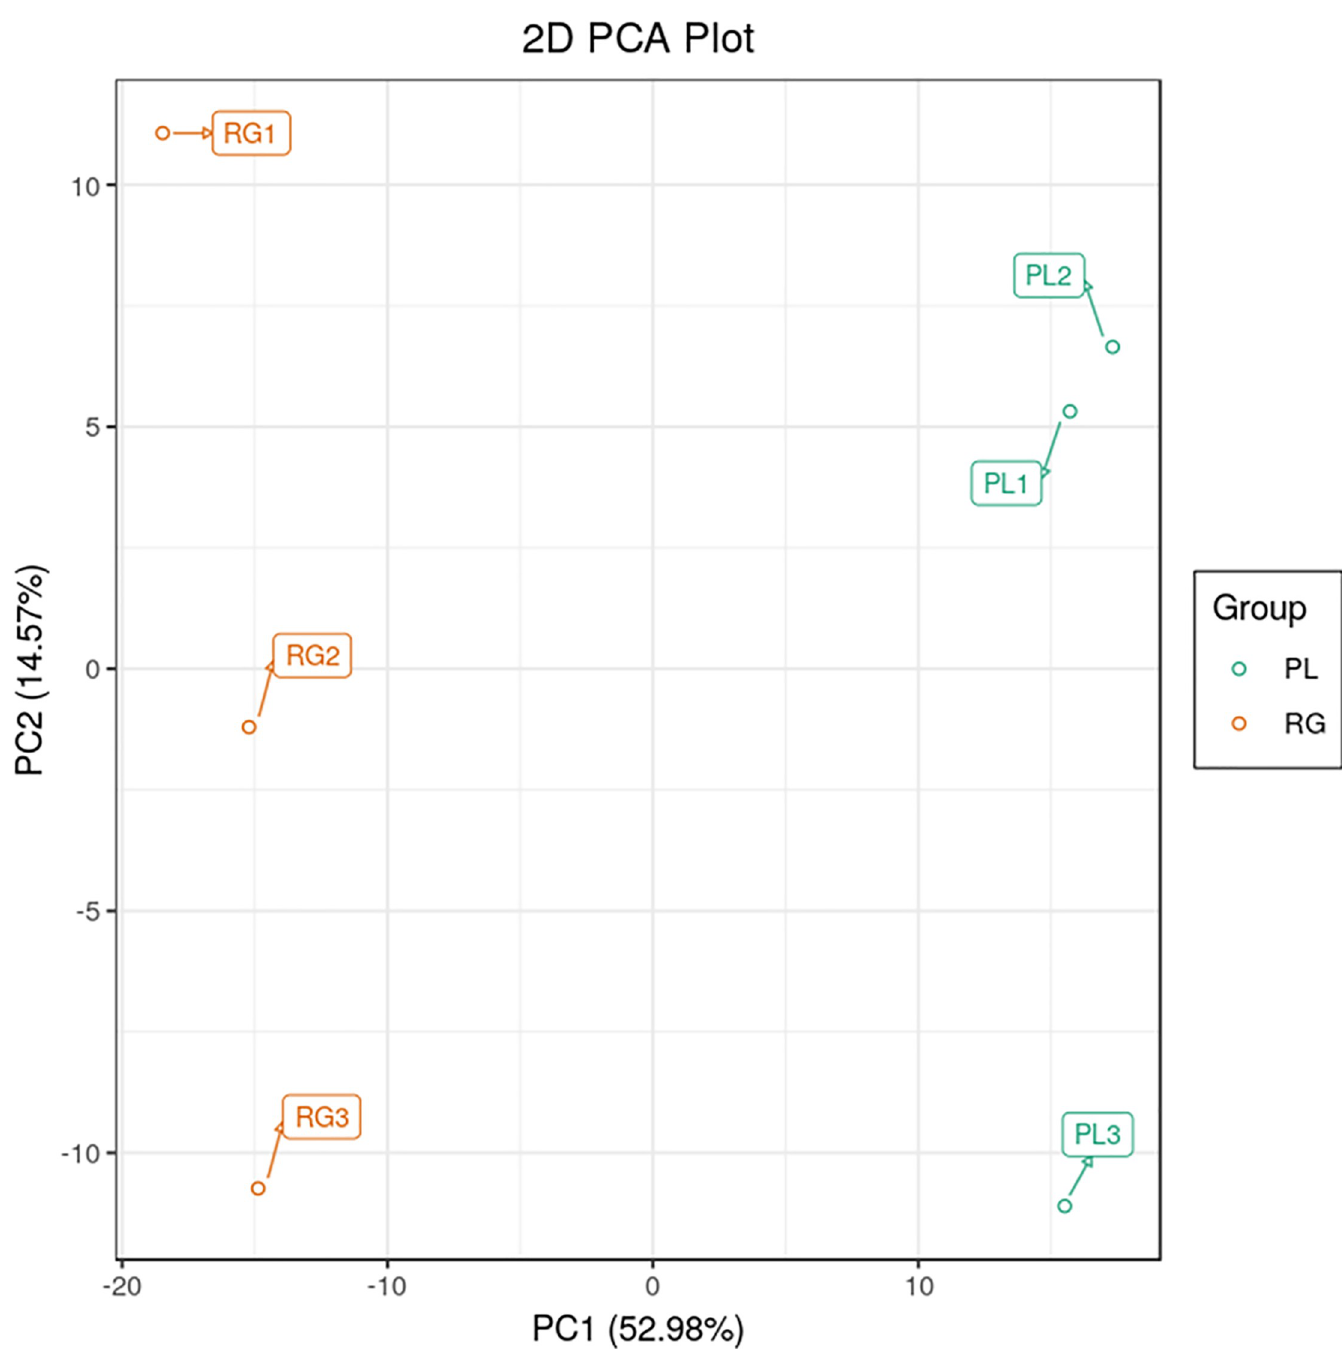
Fig 3. PCA score plot of SYQ purple and green